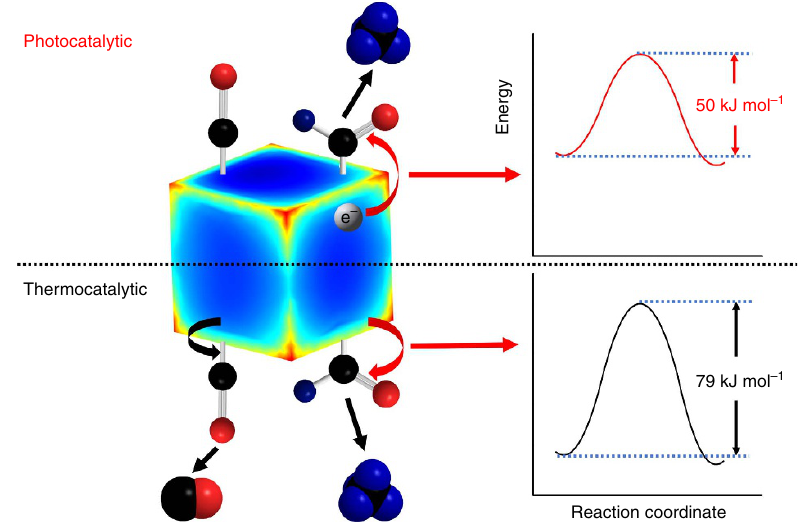
Figure 5 | Reaction mechanism on a rhodium nanocube. The thermocatalytic reaction activates both CO–Rh bonds and CH–O bonds to produce CO and CH 4 , respectively. Hot electrons generated in the photocatalytic reaction selectively activate the C–O bonds of the CHO intermediate and reduce the apparent activation energy to enhance the CH 4 production rate. The black, red, and blue spheres are carbon, oxygen, and hydrogen atoms, respectively. The red corners of the cube show the intense electric field from the excitation of LSPRs 38